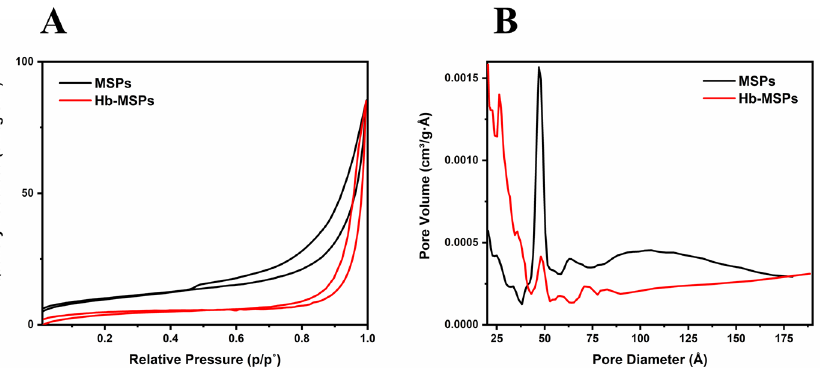
Figure 2. ( A ) Nitrogen adsorption-desorption isotherms of MSPs and Hb-MSPs. ( B ) Plots of pore diameter vs. pore volume, as calculated from the desorption isotherms using the Barrett–Joyner– Helenda